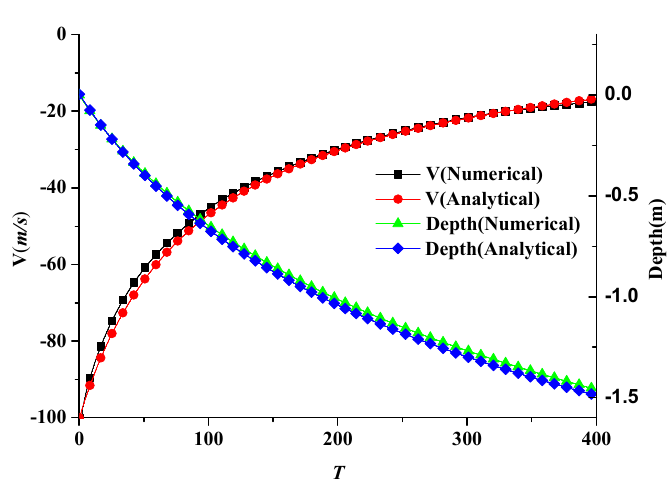
Figure 2. Comparison of numerical and analytical results of vertical water entry.